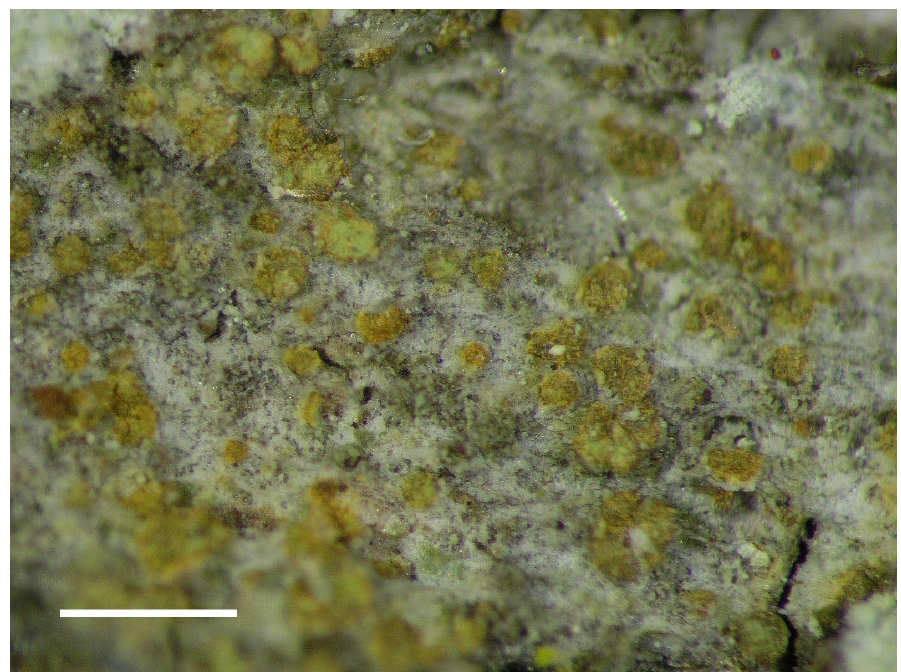
Fig. 1. Habit of Caloplaca lucifuga (OLTC-L 3227 ); scale bar = 1